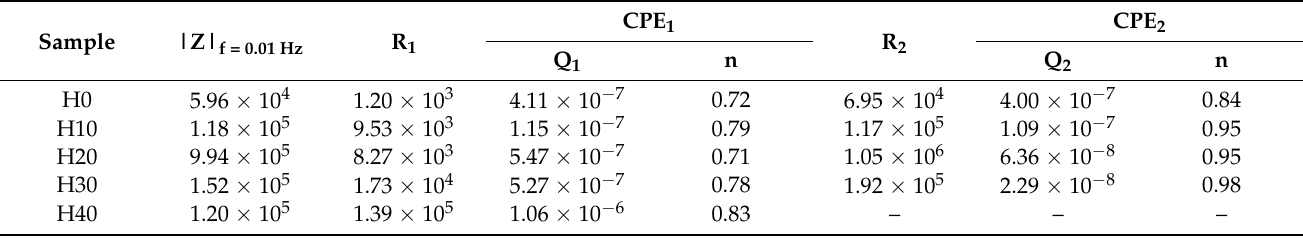
Table 6. Calculated parameters of equivalent electrical circuits (the units of R and |Z| f = 0.01 Hz are Ω × cm 2 ; Q are S × cm − 2 × s n ) for the coatings after 24 h immersion in 3.5 wt.% NaCl aqueous solution. |Z| f = 0.01 Hz was measured at the frequency f = 0.01